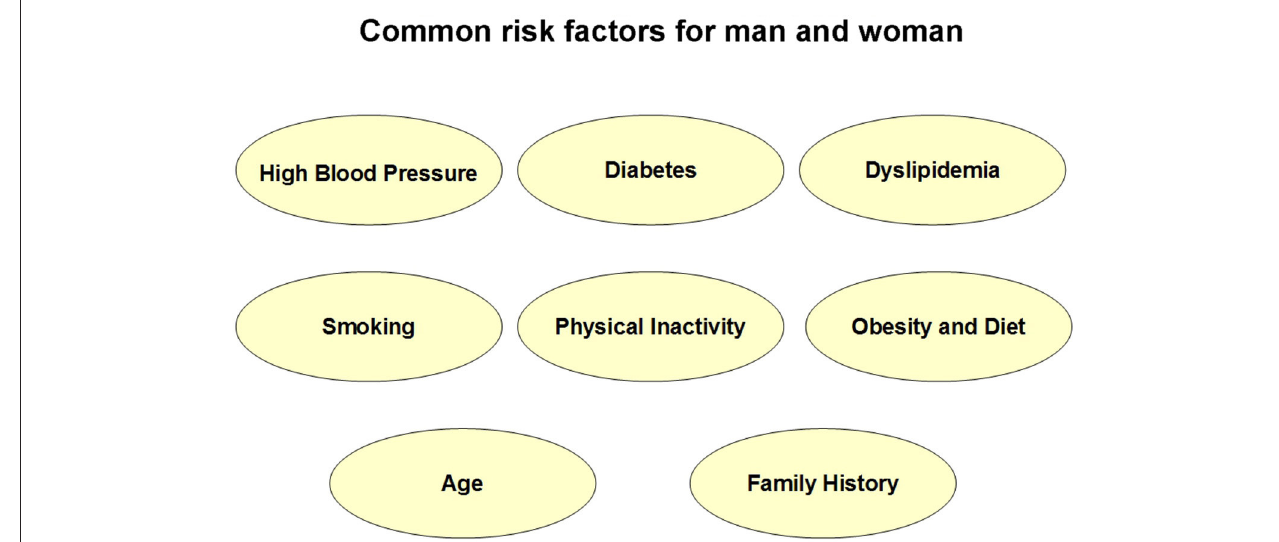
FIGURE 1 | Common risk factors for man and woman.